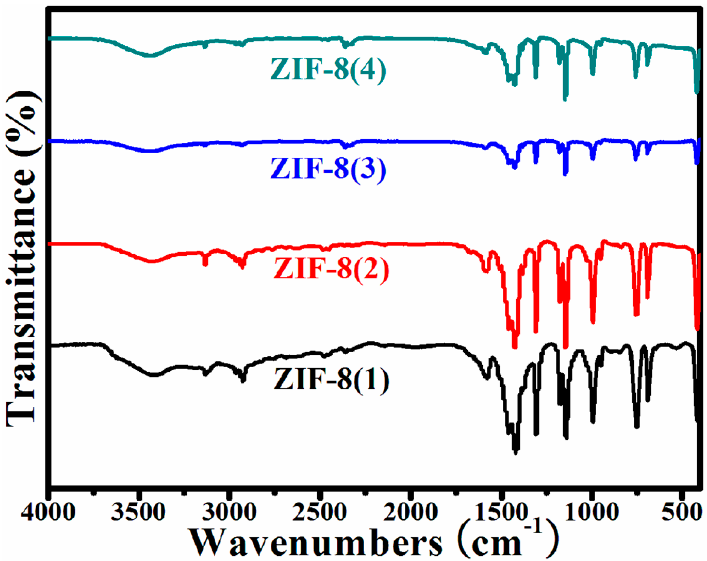
Figure 3. FT-IR spectra of ZIF-8(1), ZIF-8(2), ZIF-8(3), and ZIF-8(4).